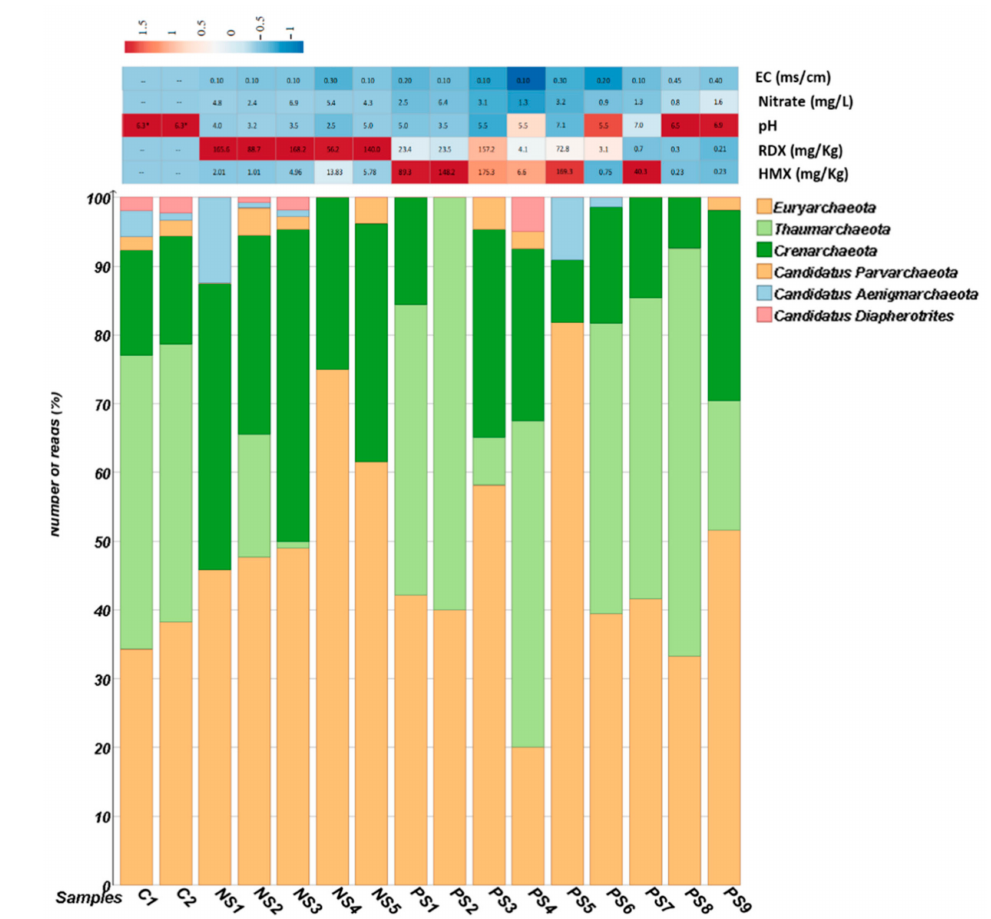
Figure 1. Dual bar chart represent phylum level distribution with levels of HMX, RDX and nitrate in samples collected from both sites. (*) represents data obtained from [26]. (–) represents data not